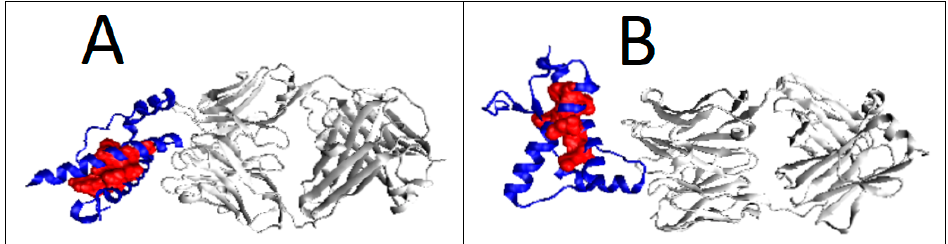
Figure 12. Different organization of the hydrophobic core structure in prion proteins included in the complex with the Fab fragment of IgG. ( A ) 6AQ7; ( B ) 4MA8.